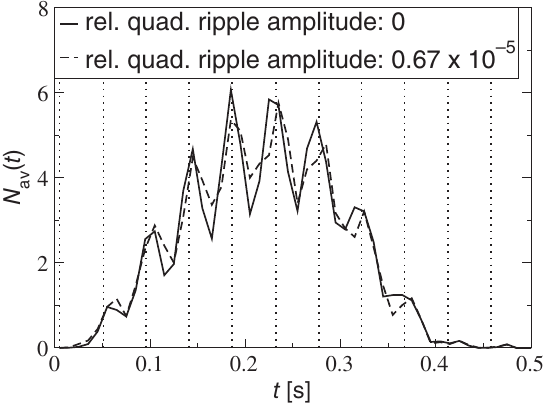
FIG. 5. Spill of an Ar 18 þ beam obtained in a slow extraction simulation for SIS18 conditions at the beam energy E ¼ 500 MeV = u, where V ¼ 12 kV, h ¼ 5 , and quadrupole rf ripples of two different amplitudes are applied. The transverse beam emittances correspond to the machine acceptance at injection reduced by the factor of 0.2 and adiabatic shrinkage during acceleration afterward. Furthermore, the maximum mo- ¼ 5 × 10 − 4 . Both the mentum deviation in the bunches is δ m transverse emittances and the maximum momentum deviation are lower than during the usual SIS18 operation. The dotted vertical lines mark the moments when the machine tune crosses a synchrobetatron resonance. The third integer resonance corre- sponding to m ¼ 0 in Eq. (20) is crossed at t ¼ 0 . 41 s.